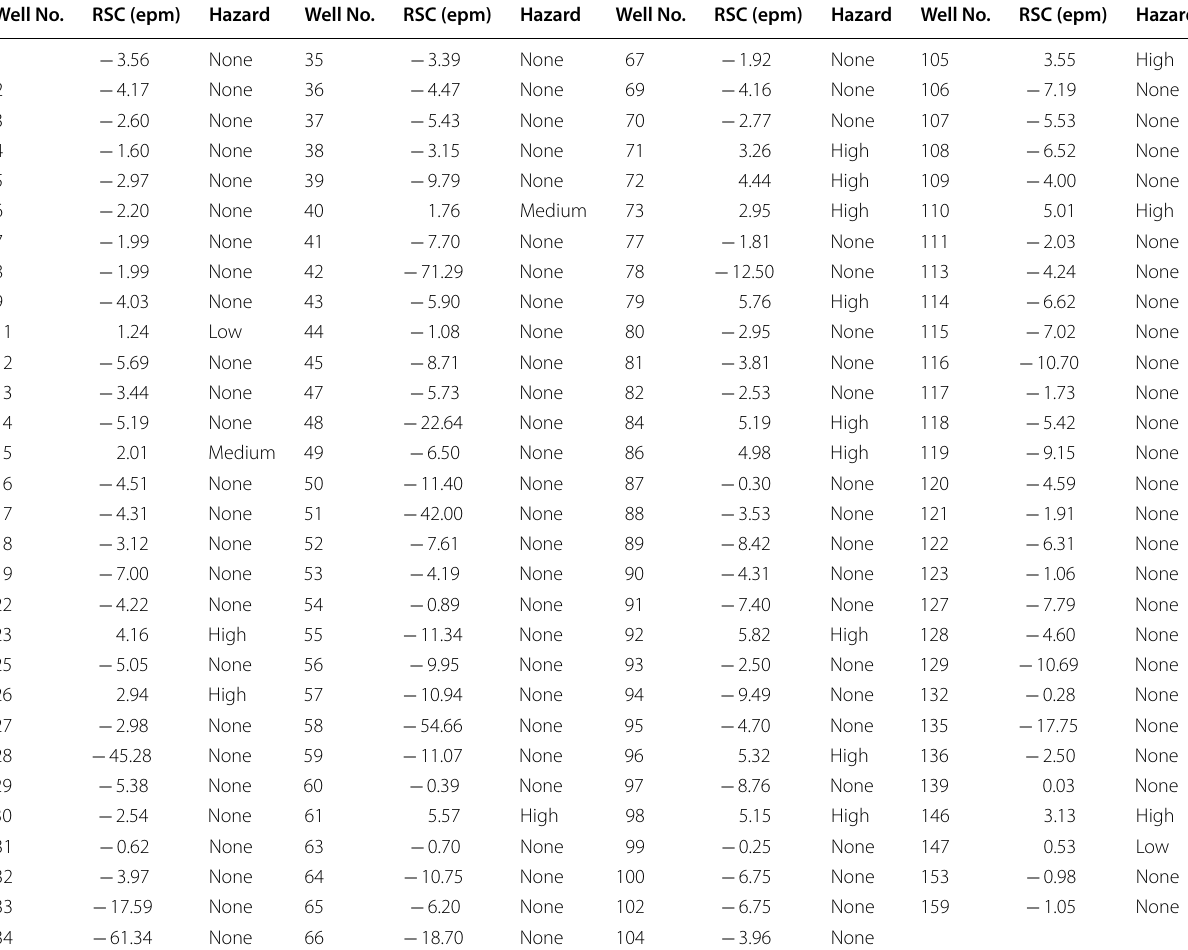
Table 12 Evaluation of groundwater samples for irrigation uses according to their RSC content Well No. RSC (epm) Hazard Well No.